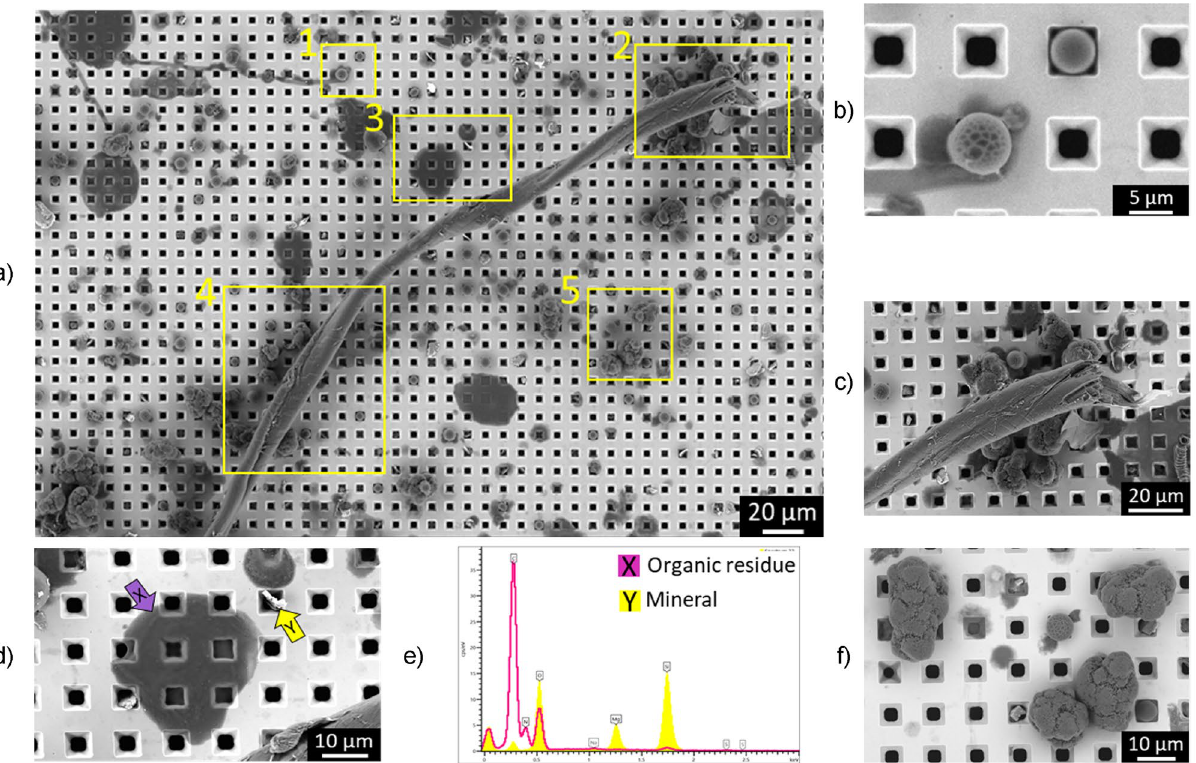
Figure 3. SEM–EDX analysis of a part of the filtered area for a spiked commercial cow’s milk sample (brand C, skimmed milk, 0.1% fat) showing: ( a ) different yellow zones (numbered 1 to 5) with different types of particles identified in each zone. Zone 1 = PS and PMMA beads; zone 2 = undigested organic fiber with agglomerates of other particles including polymer standards; zone 3 = organic residue and mineral particle; zone 4 = undigested fiber; zone 5 = polymer beads (PMMA, PS) and PA particles; ( b ) magnified zone 1 showing PS and PMMA beads; ( c ) magnified zone 2 showing agglomerates of PMMA, PS and PA particles stuck to end of the fiber; ( d ) magnified zone 3 showing some organic residue and mineral particles; ( e ) EDX spectrum on the organic residue (X) and mineral particle (Y) present in panels D; ( f ) magnified zone 5 showing PA particles and PMMA/PS